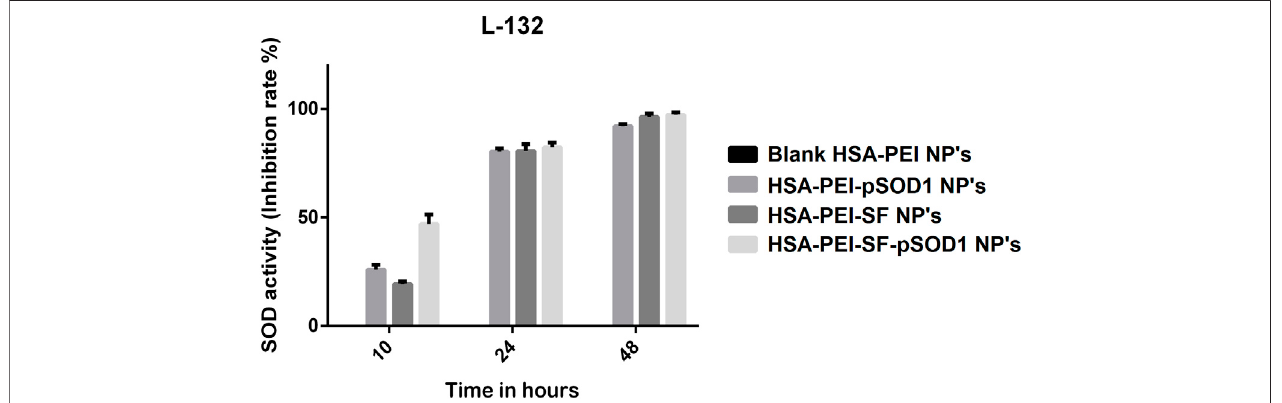
FIGURE 4 | The SOD activity (inhibition rate %) of the blank HSA-PEI Np ’ s and loaded with Sulforaphane and pSOD-1 transgene showing an elevation in SOD activity as a function of time.